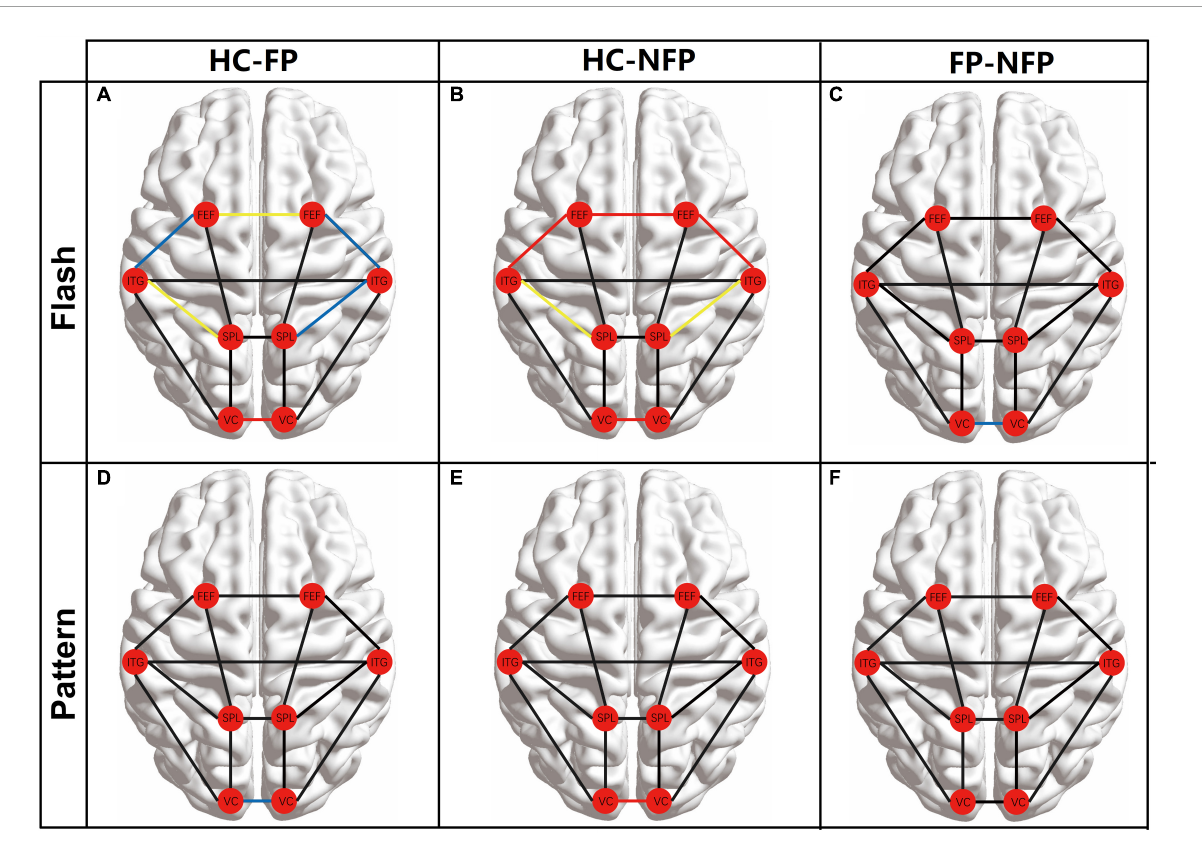
FIGURE5 Comparison of the main FC between the eight ROIs among participants in the three groups. (A) Comparison of FC between participants from the HC and FP groups in the flash visual task. (B) FC comparison of FC between participants from the HC and NFP groups in the flash visual task. (C) Comparisons of FC between the FP and NFP groups in the flash visual task. (D) Comparison of FC between participants in the HC and FP groups in the pattern visual task. (E) Comparison of FC between participants in the HC and NFP groups in the pattern visual task. (F) Comparisons of FC between the FP and NFP groups in the pattern visual task. HC, healthy control; FP, form perception; NFP, no form perception; VC, visual cortex; SPL, superior parietal lobule; ITG, inferior temporal gyrus; FEF, frontal eye fields. Red line: P < 0.001, yellow line: P < 0.01, blue line: P < 0.05, and black line: P ≥ 0.05.